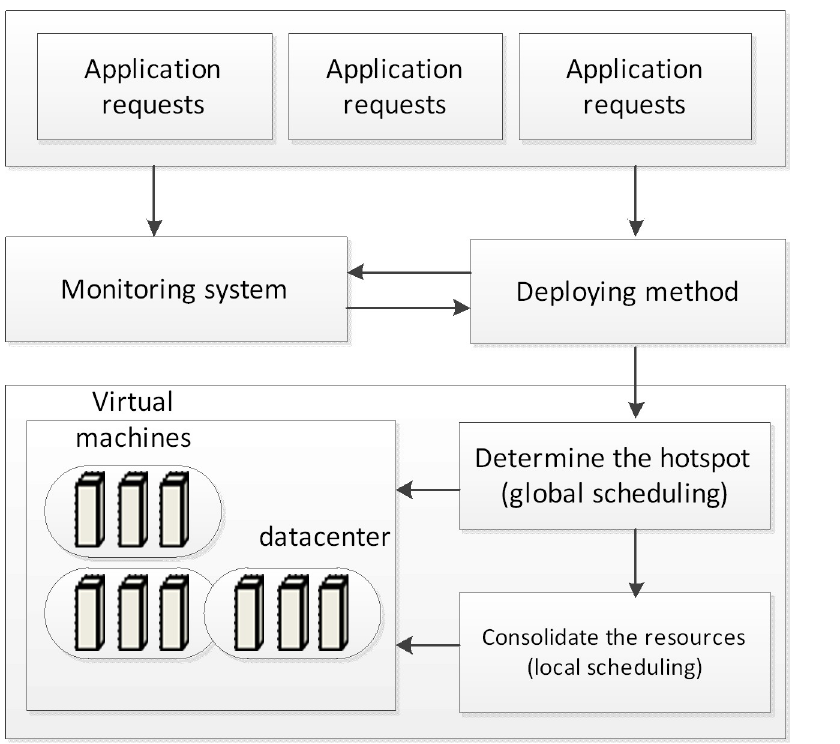
Fig 2. The main components of the